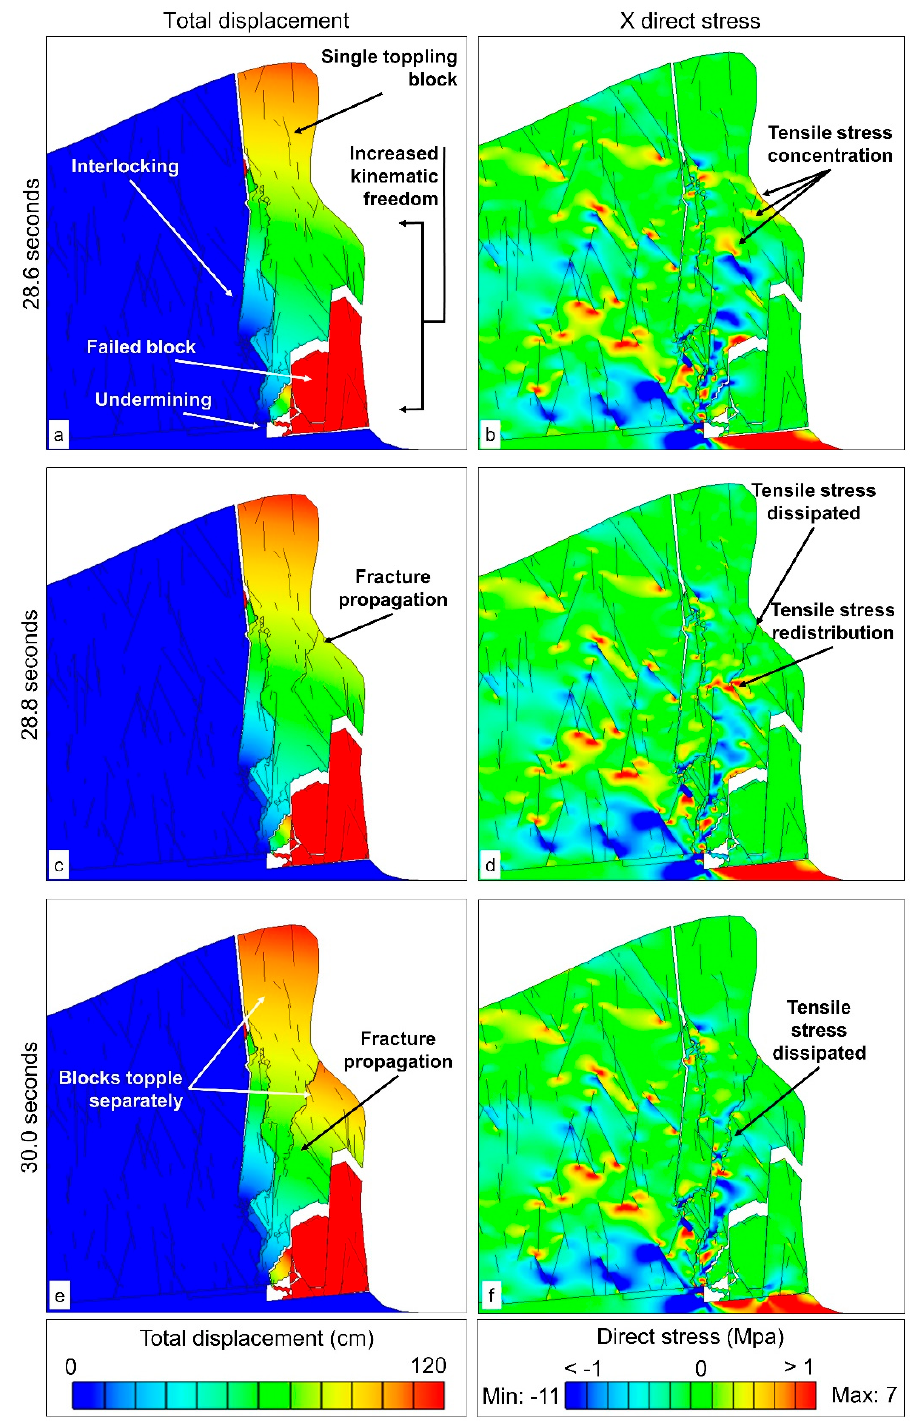
Figure 11. Brittle fracturing modelled in the unstable slab. ( a , b ) total displacement and direct stress plot at calculation time of 28.6 s. The undermining and partial failure of the slab provide an increased kinematic freedom in the lower part of the slope. Interlocking causes tensile stress concentration; ( c , d ) tensile stress exceeds tensile strength of the material and brittle fracturing occurs, dissipating and redistributing tensile stress; ( e , f ) further fracture propagation causes the lower and upper blocks to begin toppling separately.